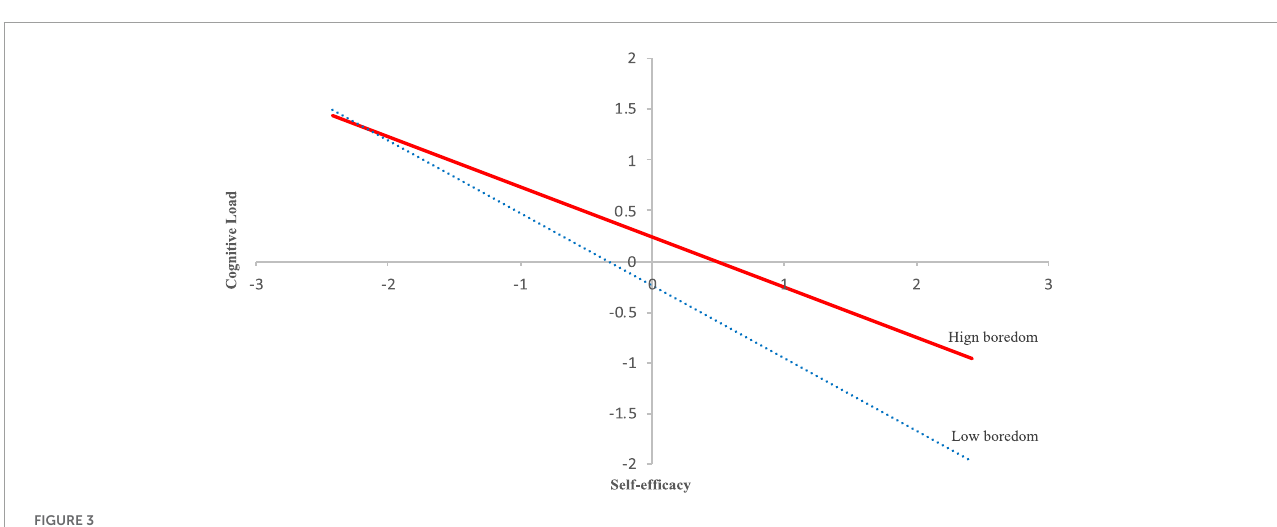
FIGURE3 The moderating effect of boredom on self-efficacy (SE) and cognitive load